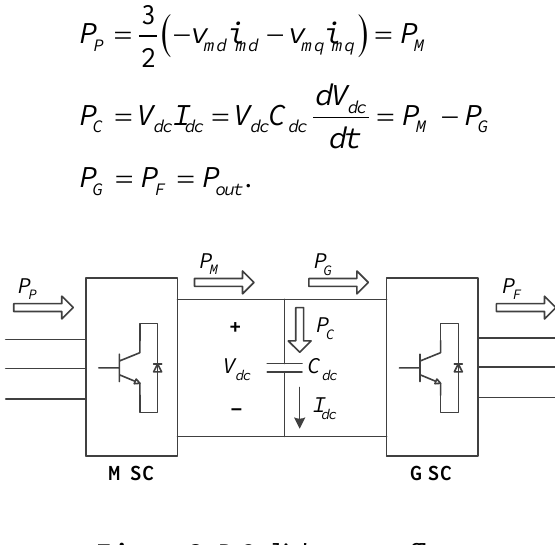
Figure 3. DC-link power